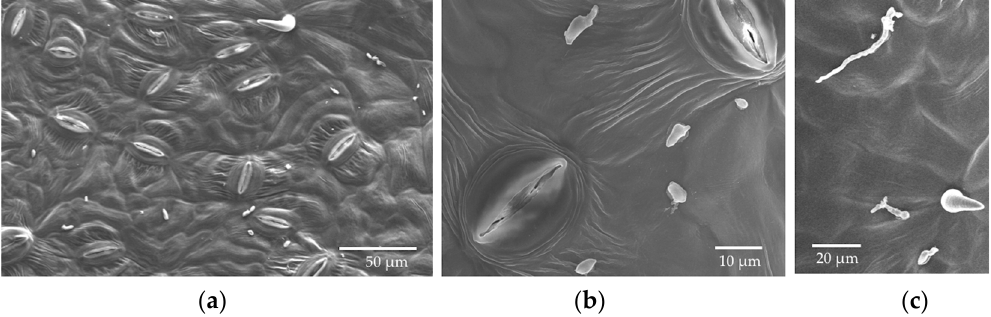
Figure 2. SEM photos from the in vitro inoculation of leaf discs of P. trichocarpa with an endophytic strain of Cladosporium tenuissimum SK2012 ( a ) Low magnification view of lower epidermis, six hours after inoculation (HAI); ( b ) Germinated and non-germinated conidia, 12 HAI; ( c ) Germinated conidia, 24 HAI.